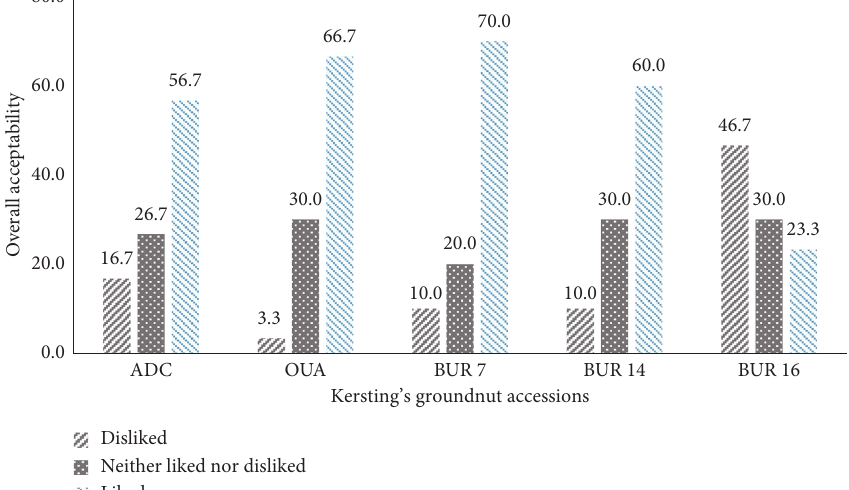
Figure 3: Overall acceptability of Kersting’s groundnut accessions. Legend: Liked: proportion of panelists who liked extremely +liked very much+liked. Disliked: proportion of panelists who disliked extremely +disliked very